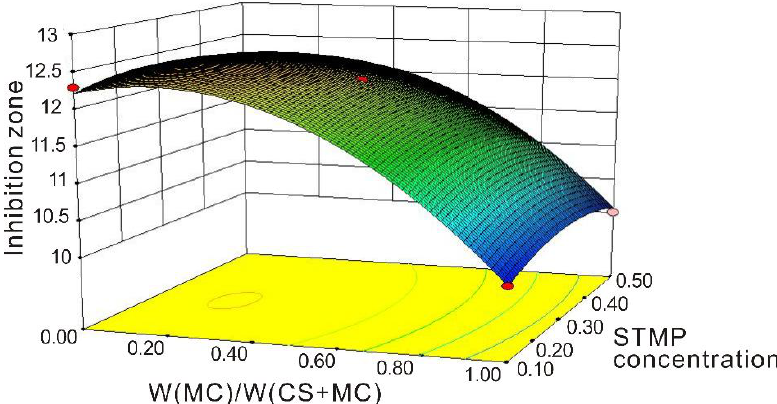
Figure 1. Surface plot (3-D) for thickness. Effect of MC/(CS + MC) and concentration of sodium trimetaphosphate on the diameter of the inhibition zone against Escherichia coli .